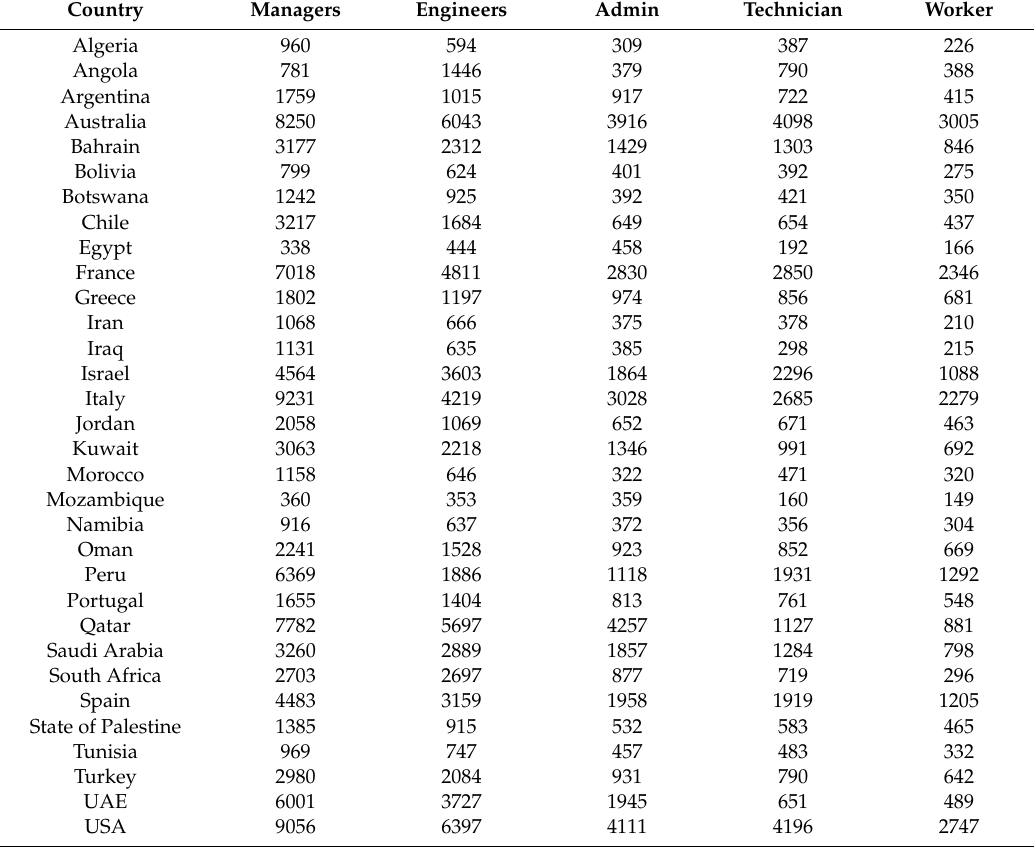
Table A3. Monthly labor rates in 2015 international dollars (rounded to full